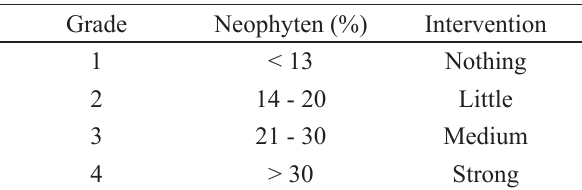
Table 8. Degrees of human intervention according to the presence of neophytes in plant communities after González (2000).